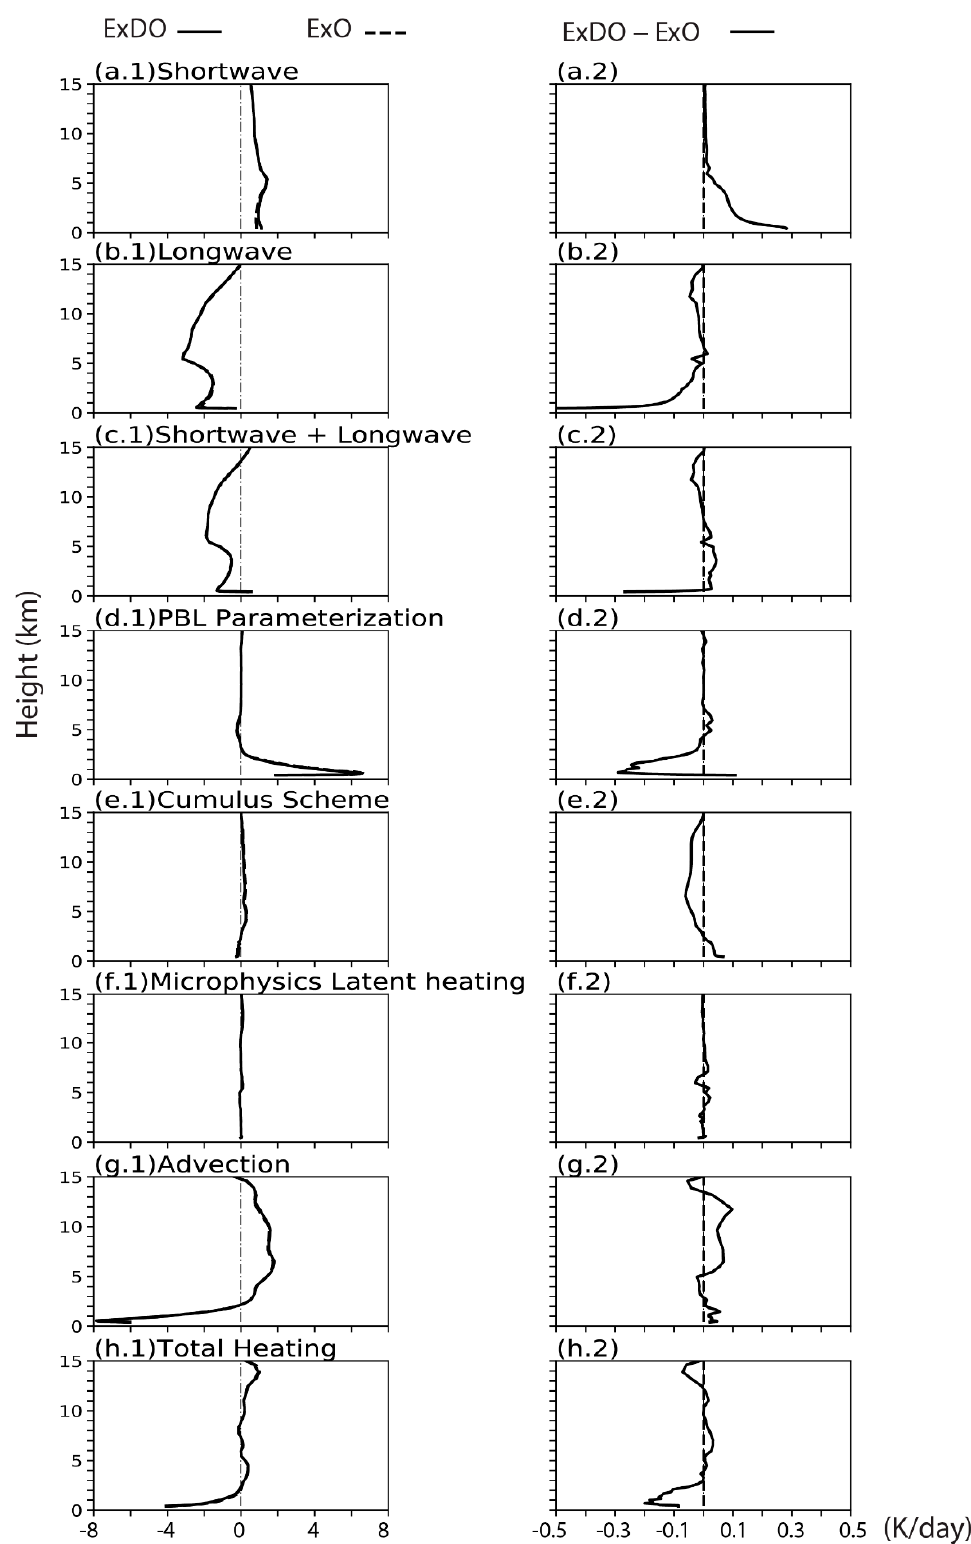
Figure 8. Same as Figure 7, except they are the heating tendencies (K/day) from different processes: SW radiation, LW radiation, SW + LW radiation, PBL parameterization, cumulus scheme, microphysics latent heat, advection, and the sum of all heating tendencies.